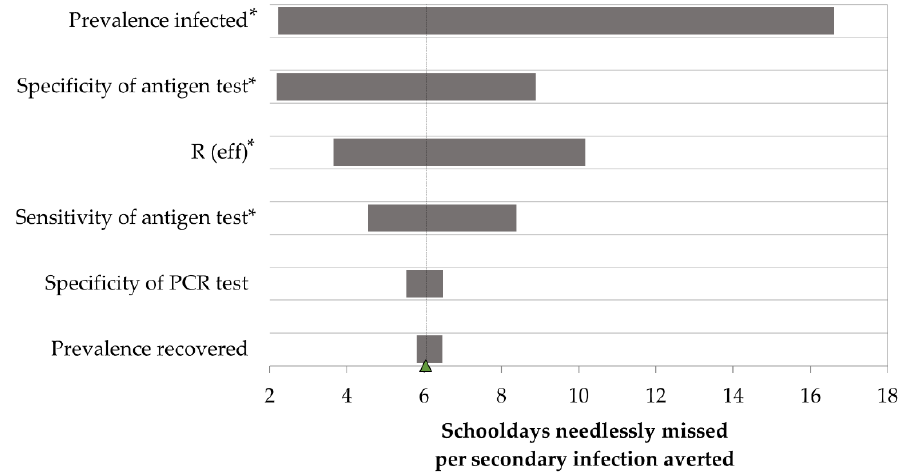
Figure 2. Tornado diagram: One-way sensitivity analyses on the efficiency of once weekly antigen testing with confirmatory PCR compared to no test. Efficiency ranges from 2.2 to 16.6 unnecessarily missed schooldays per secondary infection averted. Ag: antigen test, PCR: polymerase chain reaction test, R(eff): effective reproduction number. * Input is inversely associated with efficiency.